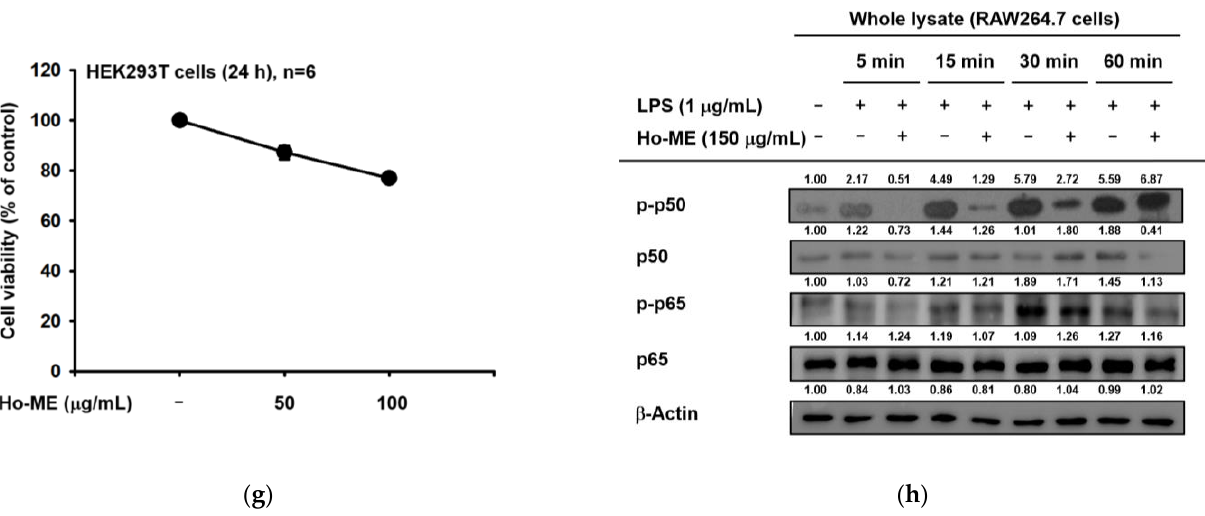
Figure 2. Ho-ME altered transcriptional activities along the NF- κ B pathway. ( a ) Semi-quantitative PCR results of proinflammatory cytokine- and NO production-related genes. ( b – d ) The mRNA expression level of each gene was quantified by qRT-PCR. ( e , f ) MyD88- or TRIF-activated NF- κ B activities were analyzed via a luciferase assay in HEK293T cells. Transcriptional activities were calculated by luminescence. ( g ) Effect of Ho-ME on HEK293T cell viability. ( h ) After Ho-ME treatment, phosphorylation level changes of NF- κ B subunits were detected with Western blot. The numbers above each cell in ( a ) and ( h ) are relative intensity values, measured using ImageJ software (Wayne Rasband, NIH, Bethesda, MD, USA). ##: p < 0.01 compared to the non-stimulated group and **: p < 0.01 compared to the control groups.